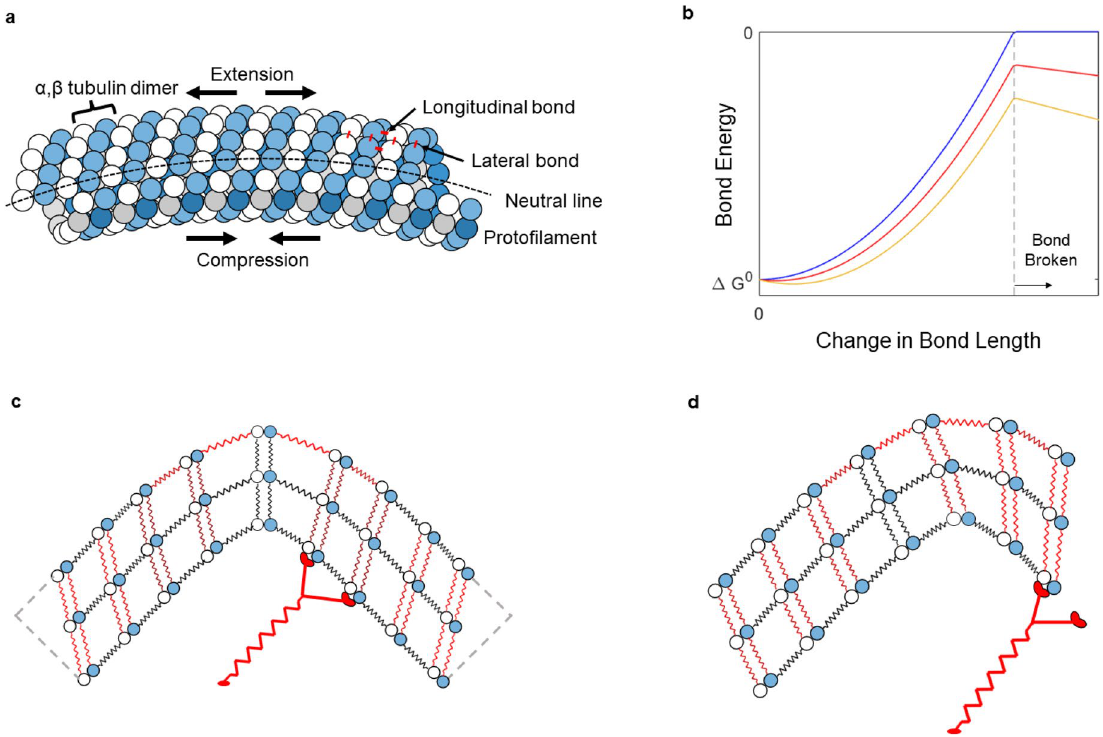
Figure 6. Strain distribution in a curved microtubule. ( a ) Lateral view. ( b ) Bond energy as a function of bond length in the absence of a bending induced stretching force (blue line), and in the presence of two levels of a bending induced stretching force (red and yellow lines). Schematic of bond energies during bending of ( c ) unpinned and ( d ) pinned microtubules. Red shading indicates the presence of tensile force on longitudinal and lateral dimer-dimer